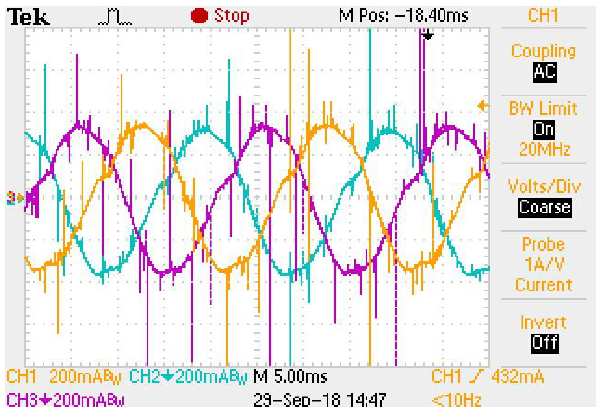
Figure 11. Experimental results outpt waveforms for the proposed modified ZSI-DCPWM with resistive load 𝑍 𝐿 = 50 Ω: ( a ) DC side voltages (input, Capacitor and DC Link voltages), ( b ) inductor current, ( c ) line voltage, ( d ) phase voltage, ( e ) line current , ( f ) three-phase voltages. The same gain point was tested with highly inductive load impedance 𝑍 𝐿 = (50 + 𝑗95)Ω . The load filters the output line current as shown in Figure 12 to be a near-sinusoid.